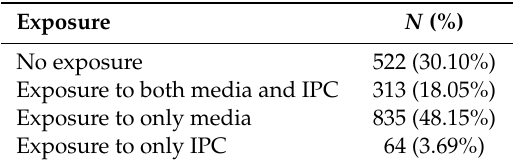
Table 2. Exposure to intervention: Media and IPC. Exposure N (%) No exposure 522 (30.10%) Exposure to both media and IPC 313 (18.05%) Exposure to only media 835 (48.15%) Exposure to only IPC 64 (3.69%)